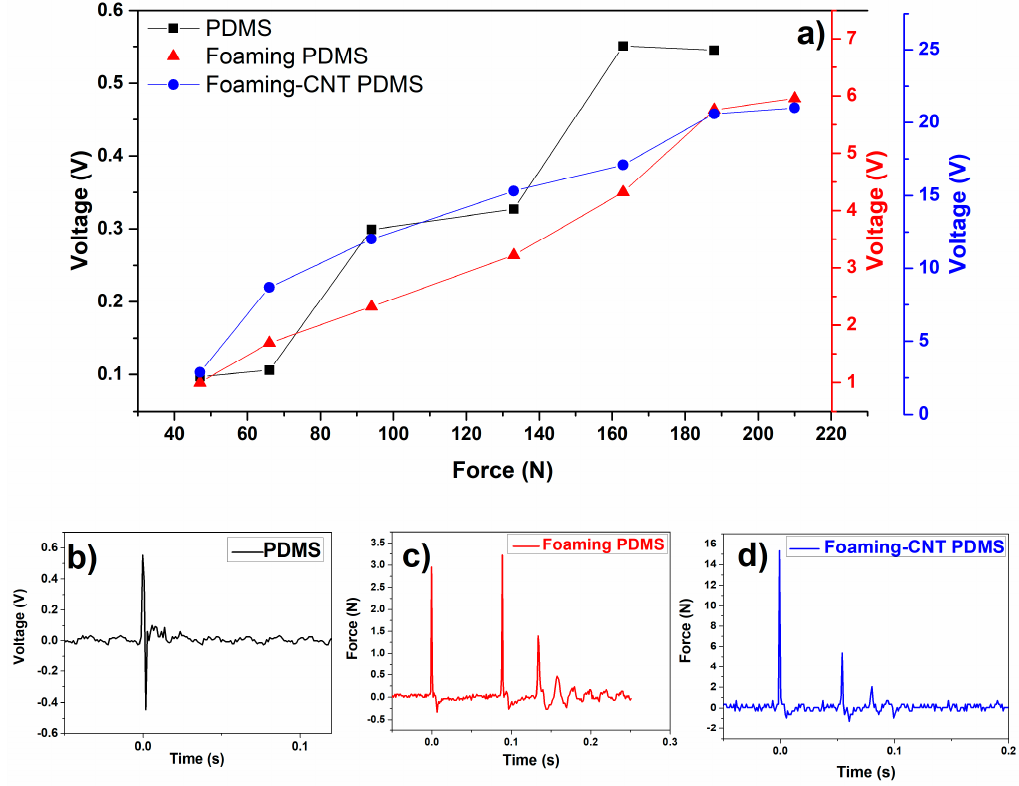
Figure 7. ( a ) Voltage outputs as a function of applied force; ( b ) voltage output pattern for TENG with pure PDMS; ( c ) voltage output pattern for TENG with undoped porous PDMS; ( d ) voltage output pattern for TENG with CNT-doped porous PDMS.